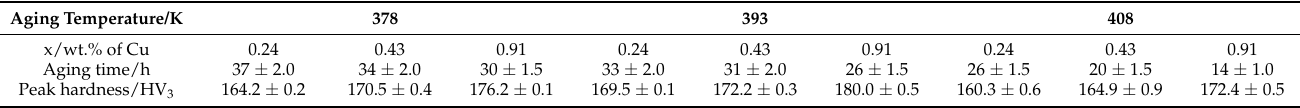
Table 2. Peak hardness and aging time of Al-5Zn-2.6Mg-xCu alloy.